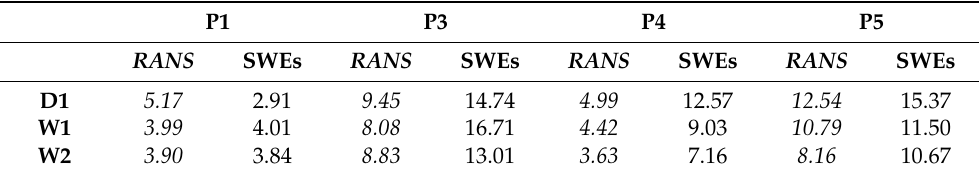
Table 2. MAPE (Mean Absolute Percentage Error) error analysis referred to the comparison between numerical (RANS and SWEs, respectively) and experimental results for water level time histories at measurement points P1, P3, P4, and